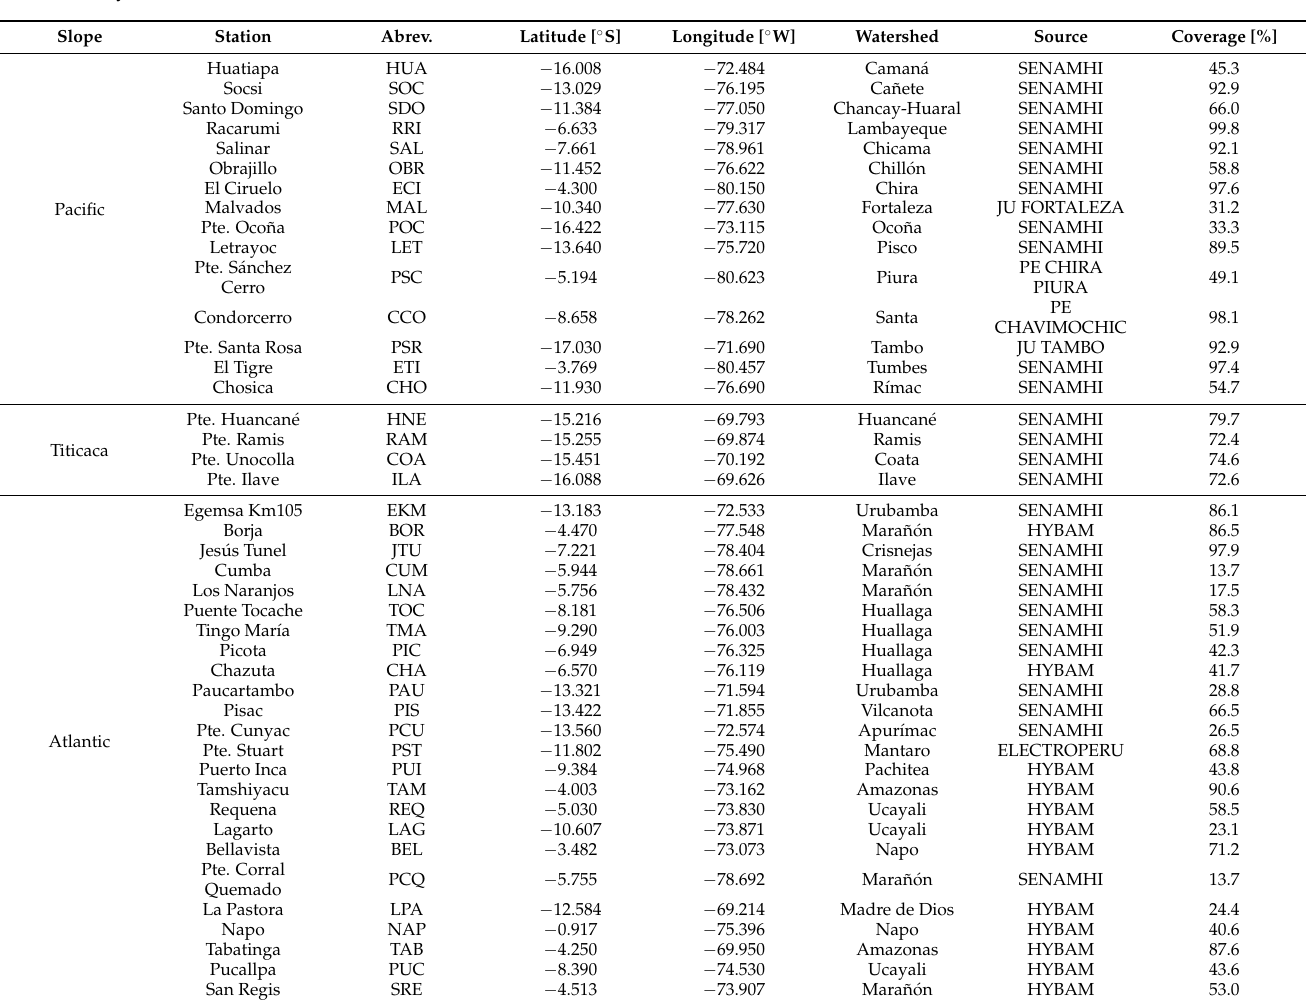
Table 1. Hydrometric stations selected for hydrological modeling at a national level. Coverage [%] is considering from January 1981 to March 2020.